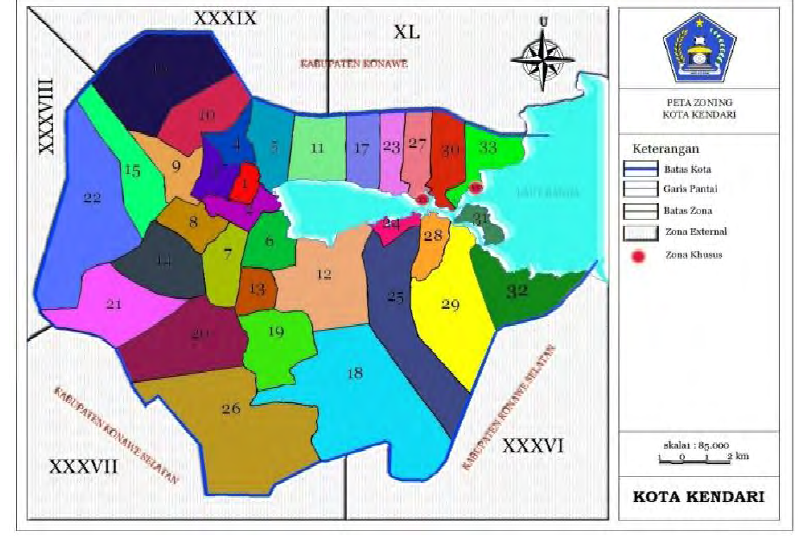
Figure 3. Distribution Zone Map